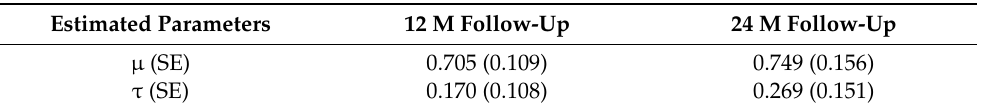
Table 3. Estimates of model parameters derived from the meta-analyses of 5 randomised clinical trials using bifocal spectacle